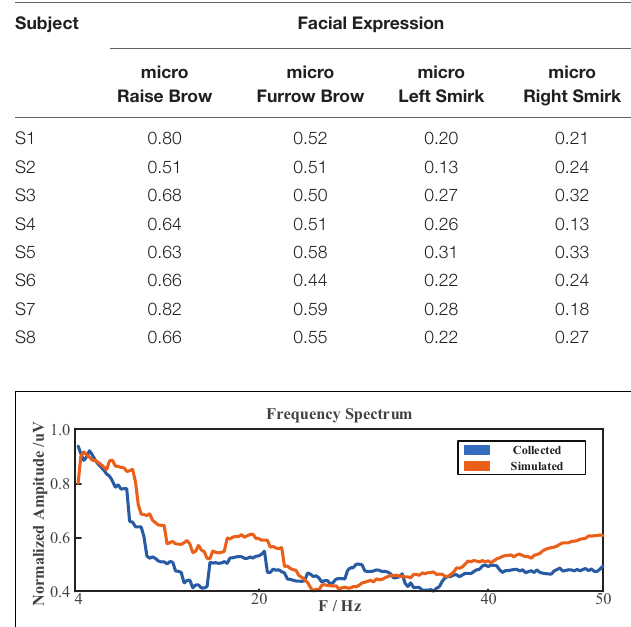
was used to model the generation of neural activity